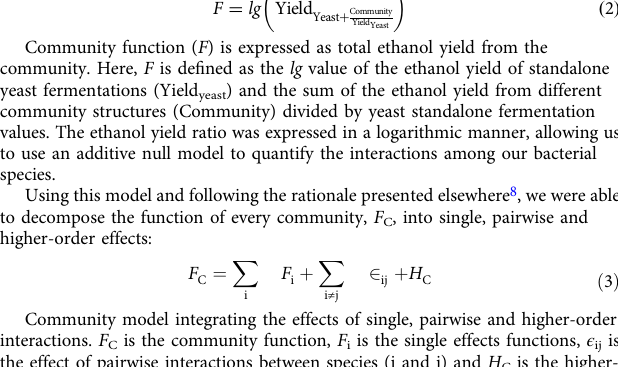
Fig. 6 The effect of Lactobacillus amylovorus on sugarcane molasses ethanol fermentations. A Comparison between ethanol yield values from yeast- based fermentations of synthetic sugarcane molasses inoculated with different concentrations of L. amylovorus cells. An increase in ethanol yield is observed following higher bacterial cell concentrations. Values over lines represent signi fi cant p values from bootstrapping. Beige circles: no L. amylovorus added in the fermentation. Green circles: L. amylovorus added in the fermentation. B The acidity titres (g organic acids L − 1 ) from fermentations inoculated with different concentrations of L. amylovorus cells. The titres increase following the higher bacterial cell concentrations, suggesting that most of this acidity increase comes from bacterial metabolism. Values over lines represent signi fi cant p values from bootstrapping. Beige circles: no L. amylovorus added in the fermentation. Green circles: L. amylovorus added in the fermentation. C Glycerol titres from fermentations inoculated with different concentrations of L. amylovorus cells. Fermentations inoculated with higher bacterial concentrations present lower glycerol titres, when compared with control conditions. Beige circles: no L. amylovorus added in the fermentation. Green circles: L. amylovorus added in the fermentation. D Average increase in yeast biomass after each fermentation cycle, from fermentations inoculated with different concentrations of L. amylovorus cells. After a fermentation cycle is over, yeast biomass is separated from the fermented broth via centrifugation and weighted. Fermentations inoculated with higher bacterial cells presented lower yeast biomass increases, albeit not signi fi cantly different from control conditions. Beige circles: no L. amylovorus added in the fermentation. Green circles: L. amylovorus added in the fermentation. E Ethanol productivity (g ethanol h − 1 ) can be inferred via CO 2 production during alcoholic fermentations, by weighting the fermentation tubes. Fermentations inoculated with higher bacterial cell concentrations presented higher productivity values, although not signi fi cantly different from control conditions. Beige circles: no L. amylovorus added in the fermentation. Green circles: L. amylovorus added in the fermentation. F Yeast viability from fermentations inoculated with difference concentrations of L. amylovorus cells. No difference can be observed among all treatments. Beige circles: no L. amylovorus added in the fermentation. Green circles: L. amylovorus added in the fermentation. For all the results presented in this fi gure, n =